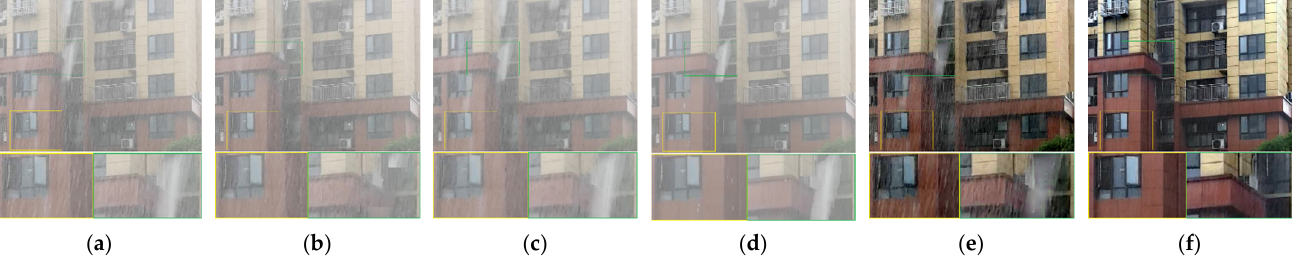
( f ) Figure 9. Comparison on a real rain video. ( a ) Input, ( b ) Kim et al. [16], ( c ) Wang et al. [8], ( d ) Li et al. [14], ( e ) Chen et al. [32], ( f ) proposed method.